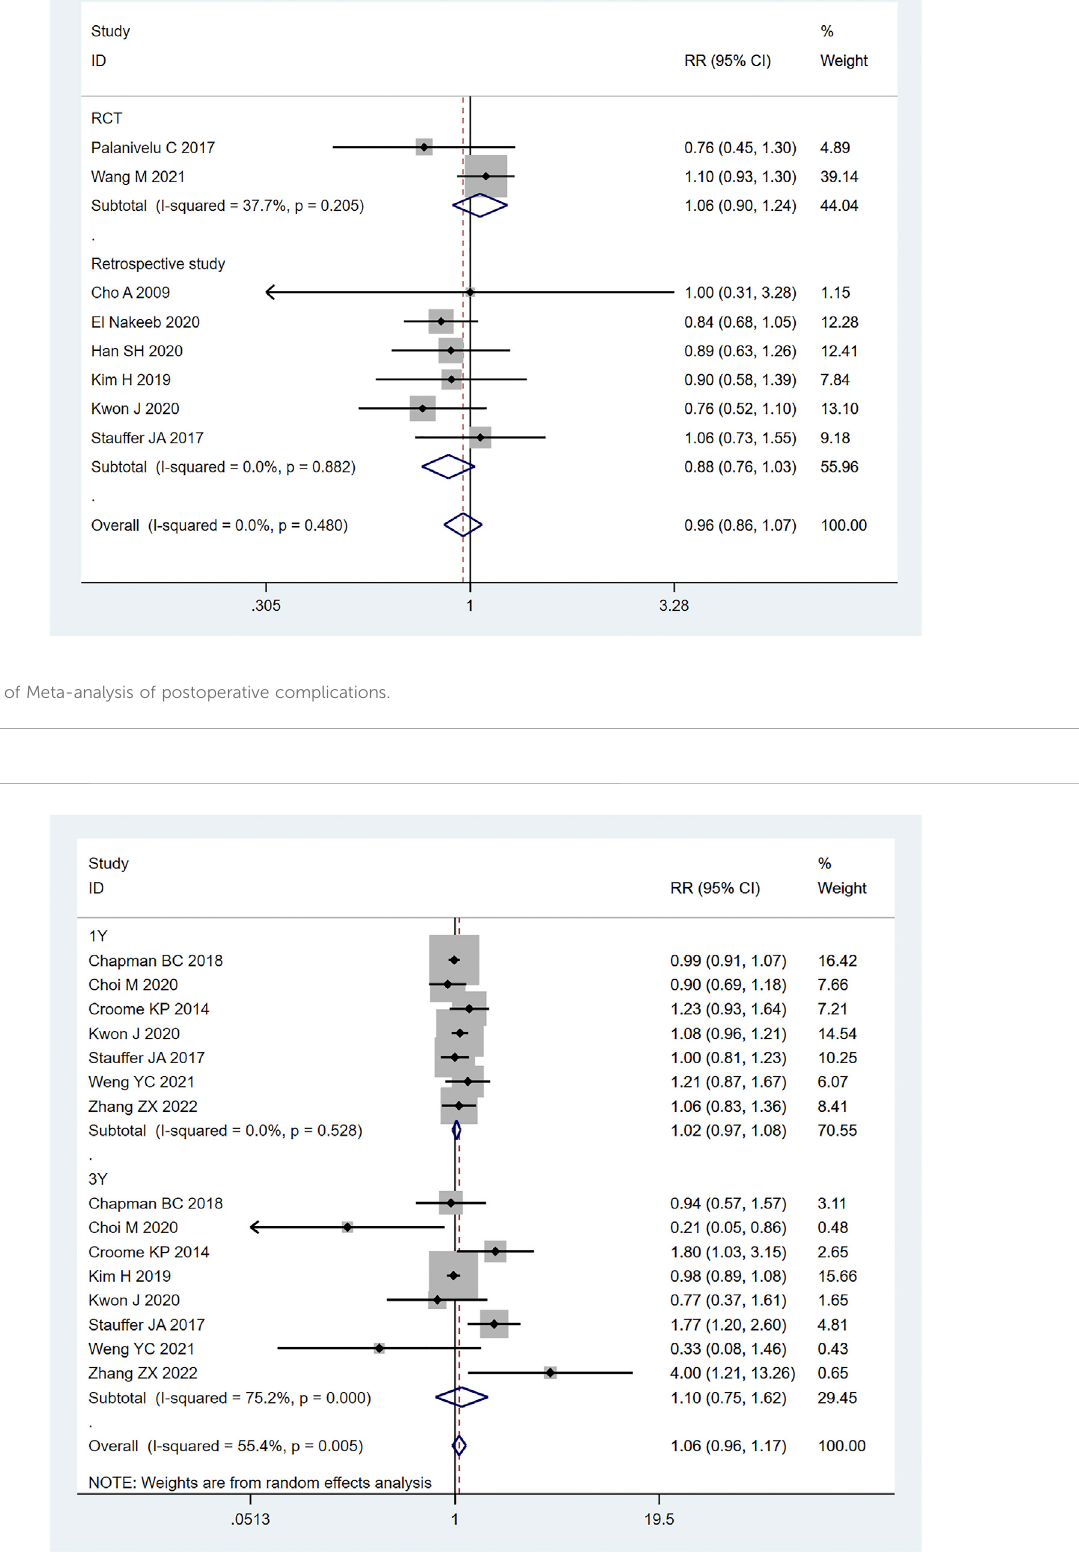
FIGURE 9 Forest plot of Meta-analysis of